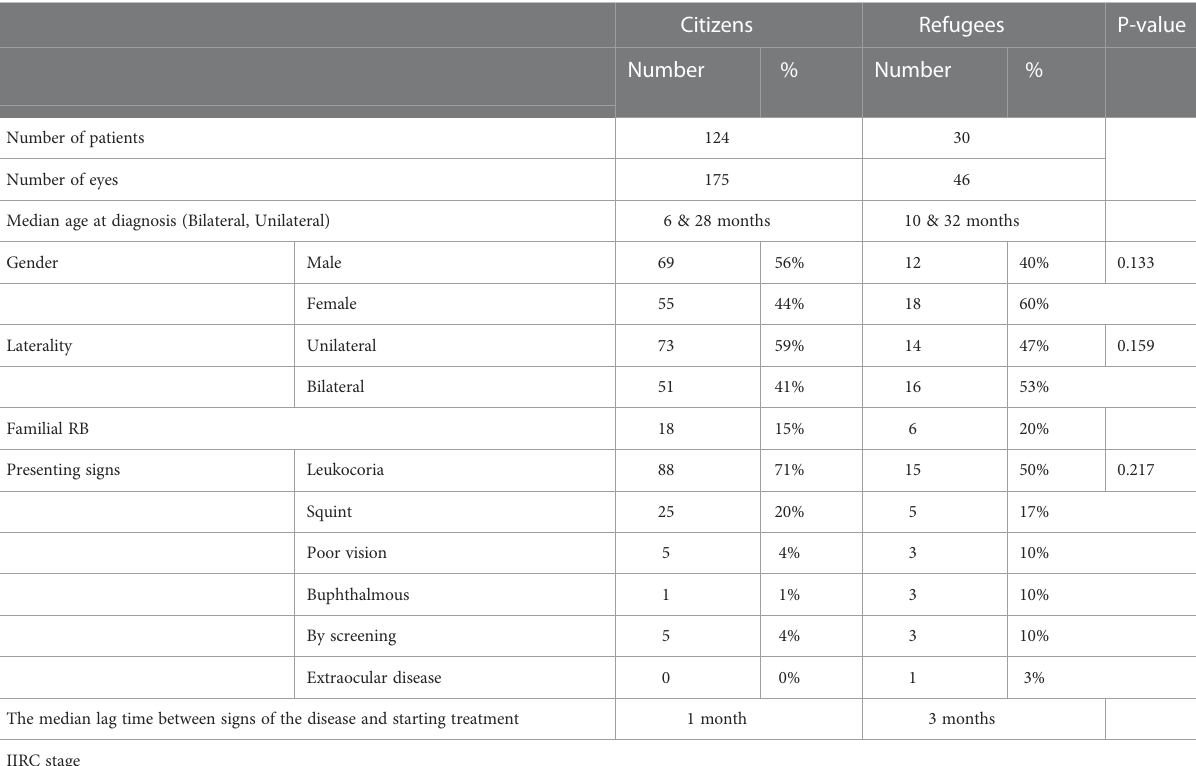
TABLE 3 Comparison between Jordanian RB patients and Refuges with RB diagnosed and treated at King Hussein Cancer Center